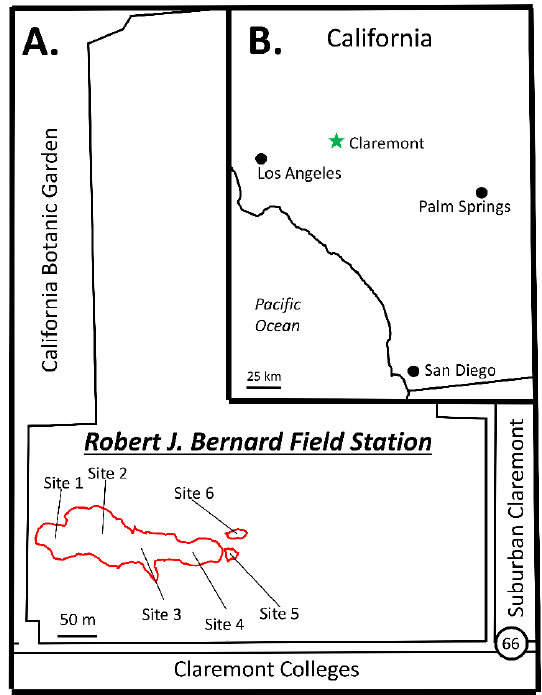
Figure 1. Map of the 2017 fire perimeter (red) and the location of the six study sites within the Robert J. Bernard Field Station (A), located in eastern Los Angeles County (B). Site 5 and 6 are in small spot fire areas.